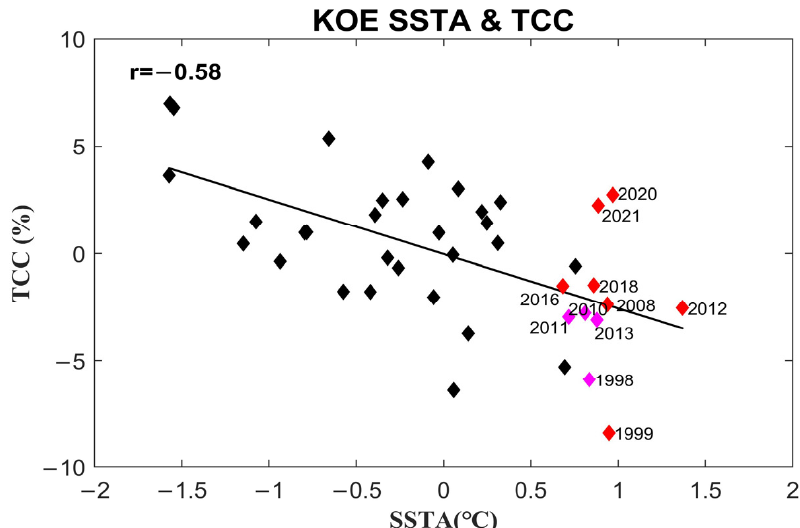
Figure A2. Scatter diagram of the JAS averaged TCC and SSTA in the KOE region. The solid line denotes the linear regression. Red dots indicate the six largest MHWs and magenta dots indicate the less strong MHWs.